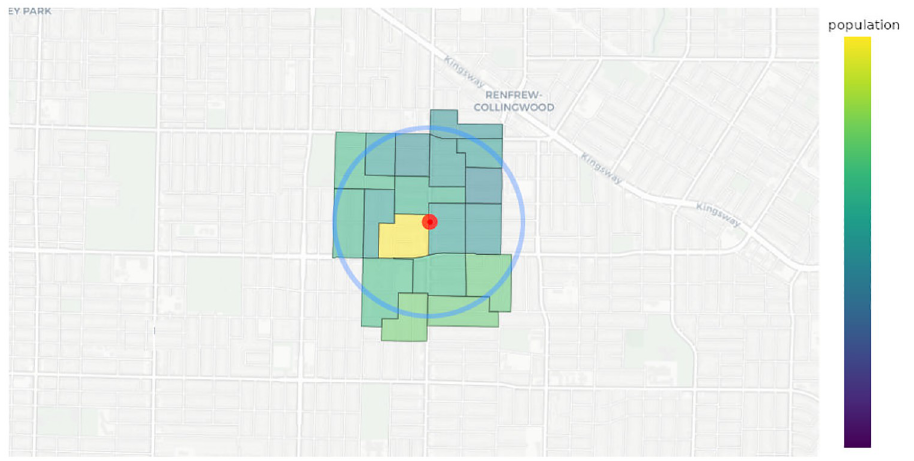
Fig 1. An illustration of an urban map where the facility j (red dot) is surrounded by its neighbouring demand nodes (coloured urban blocks). The blue circle determines the extent of the facility’s neighbourhood A j . The demand nodes are coloured according to their population